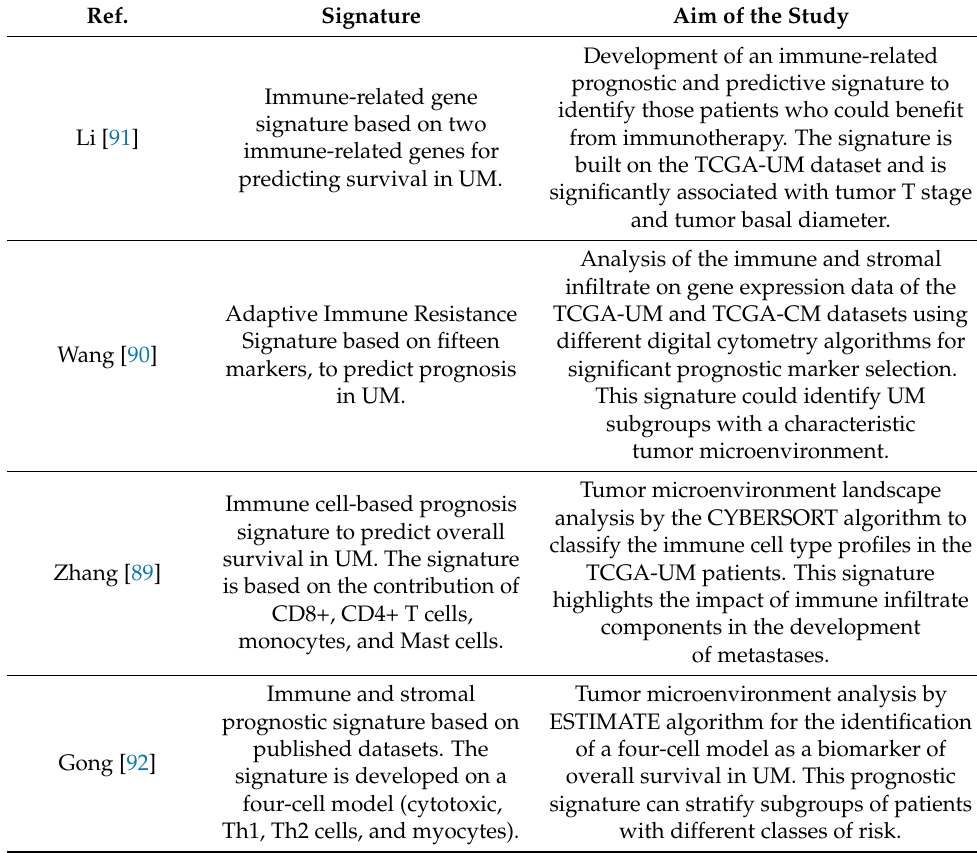
Table 4. Summary of the principal published immune